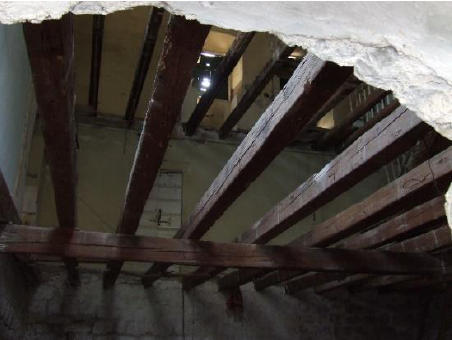
Figure 15. Wooden floor constructions attached to the walls with anchors. Figure 15. Transversal beams had the function of tie-rods.